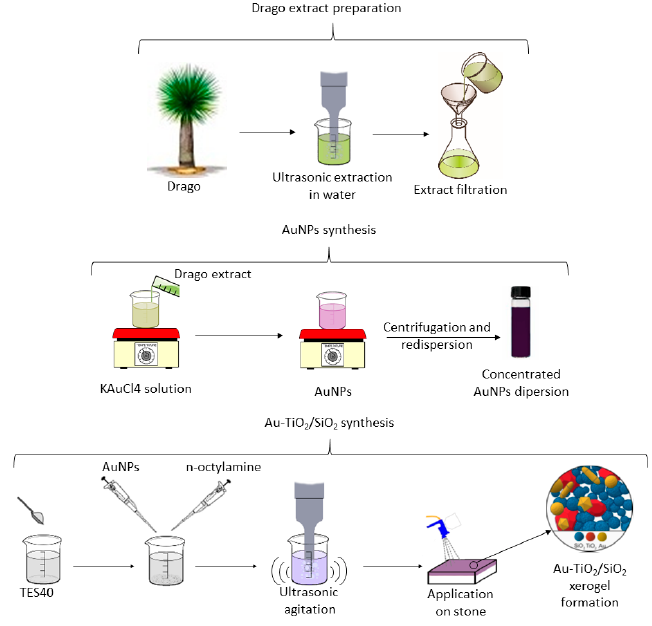
Figure 1. Au-TiO 2 /SiO 2 route synthesis and application on the stone samples.